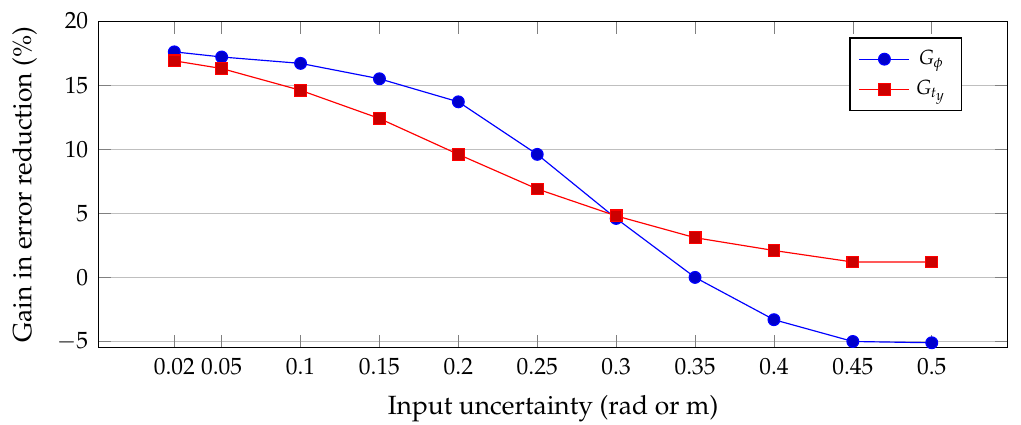
Figure 7. Gains in error reduction of the multi-pairwise approach for two variables: one rotation ( φ ) and one translation ( t y ). For input uncertainties beyond 0.35 (radians or meters) the gain become loss, and the process is no longer advantageous, ceasing the usefulness of the technique for this setup.